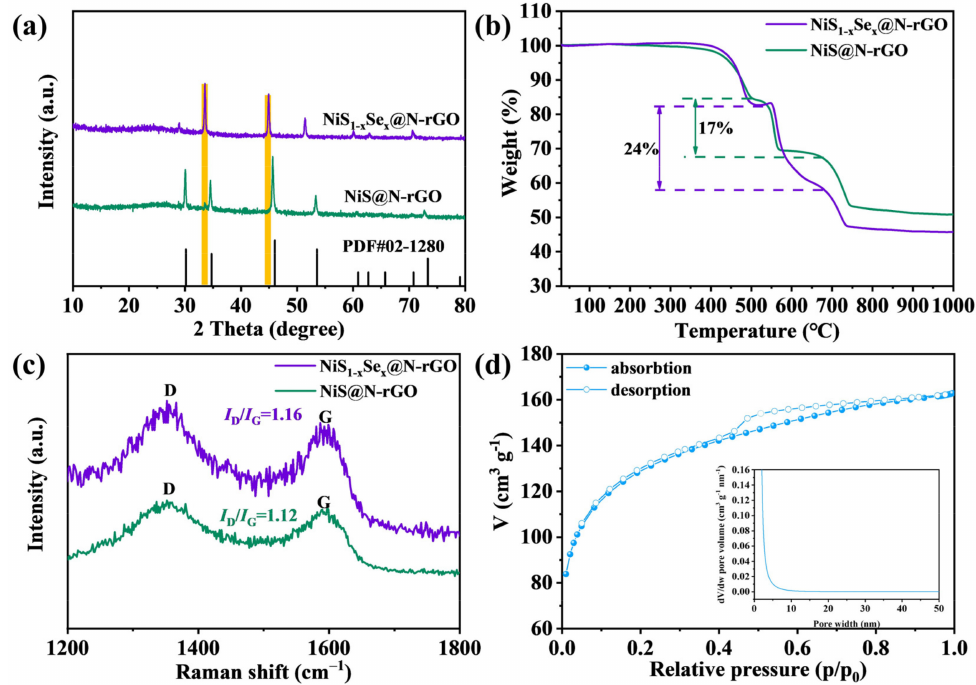
Figure 3. ( a ) XRD patterns, ( b ) TGA curves, ( c ) Raman spectra of NiS@N–rGO and NiS 1 − x Se x